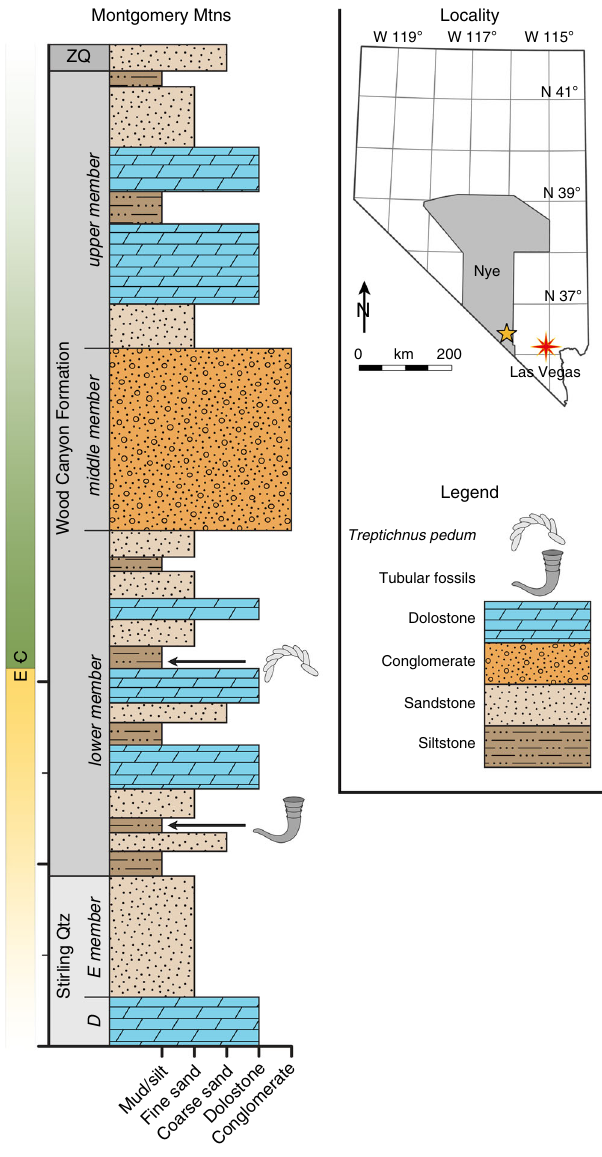
Fig. 1 Generalized stratigraphy of the Montgomery Mountains site. Ediacaran – Cambrian boundary denoted by the presence of Treptichnus pedum . Cloudinomorphs recovered from silty-shale below fi rst dolostone marker bed in the lower member of the Wood Canyon Formation. Nye County indicated on map, with yellow star marking approximate